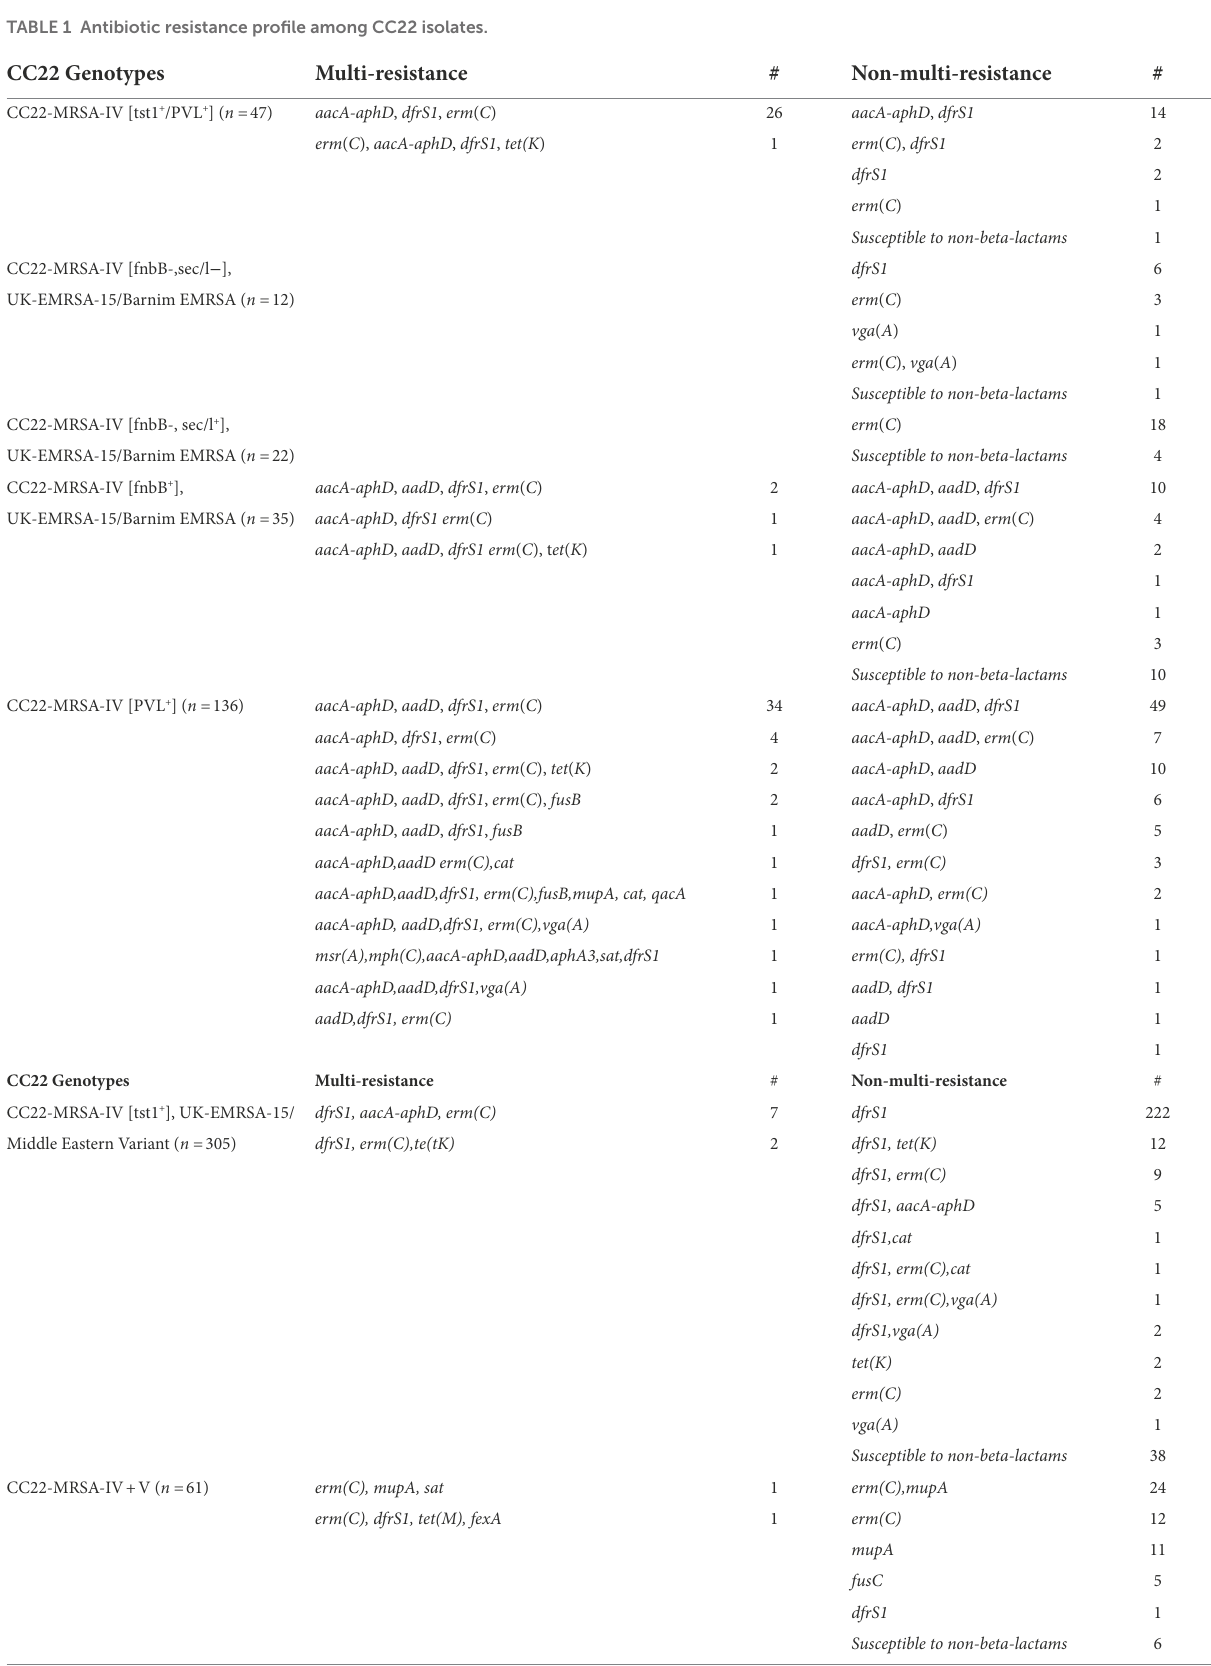
TABLE 1 Antibiotic resistance profile among CC22